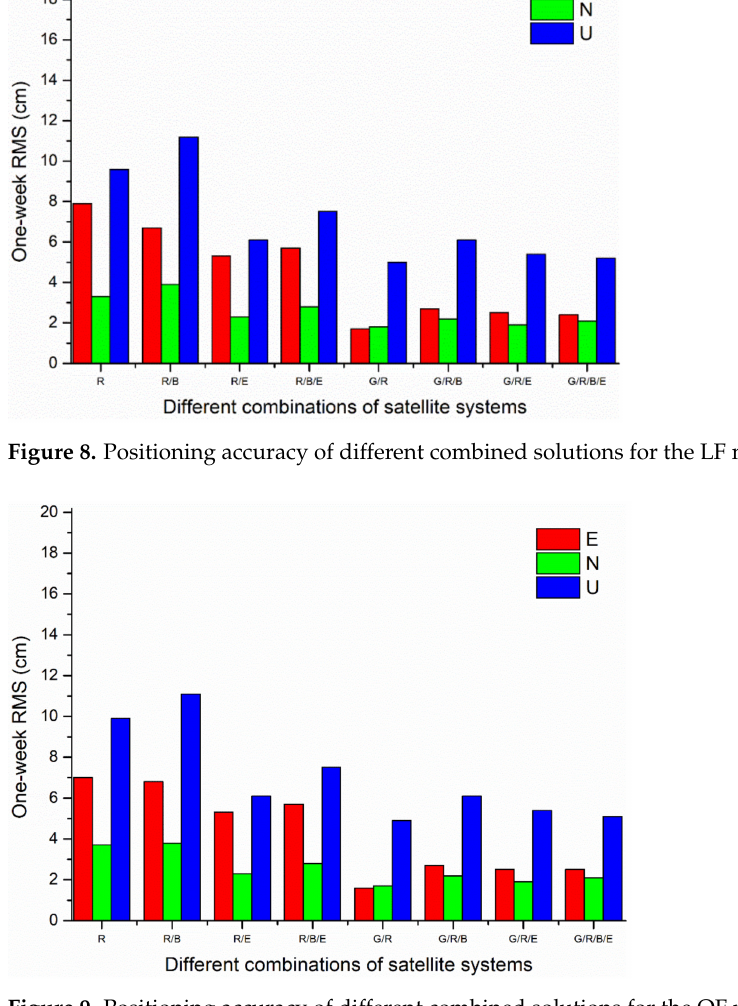
Figure 9. Positioning accuracy of different combined solutions for the QF model in kinematic